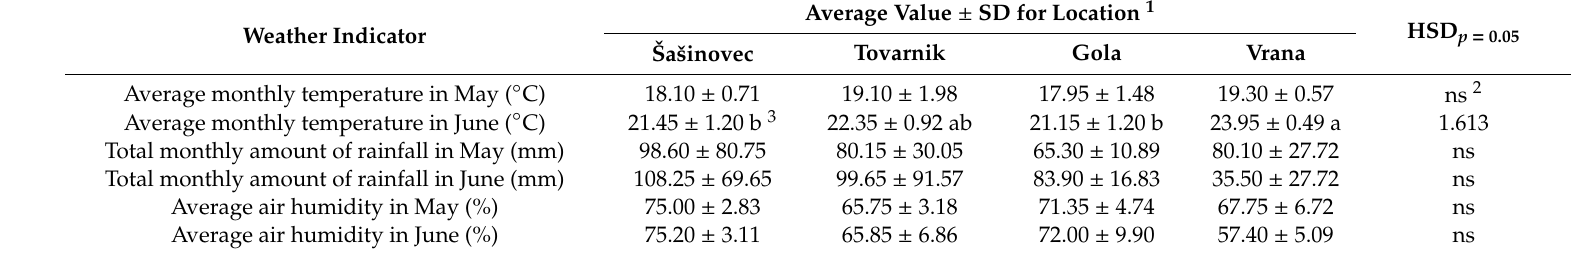
Table 2. Comparison among the locations in weather conditions (the average monthly temperature in ◦ C, total amount of rainfall in mm, and average air humidity in %) in May and June and the result of statistical